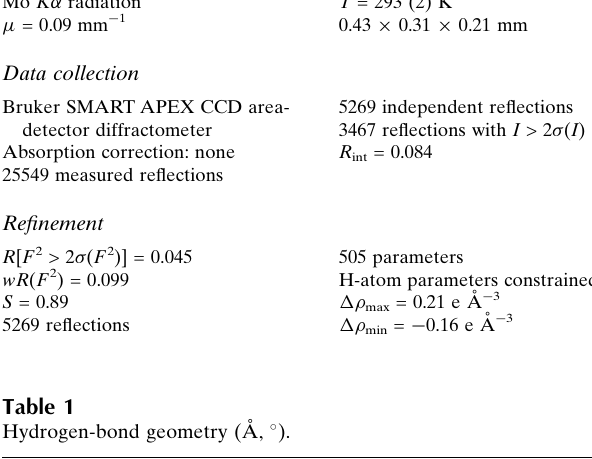
Hydrogen-bond geometry (A˚ , (cid:4)